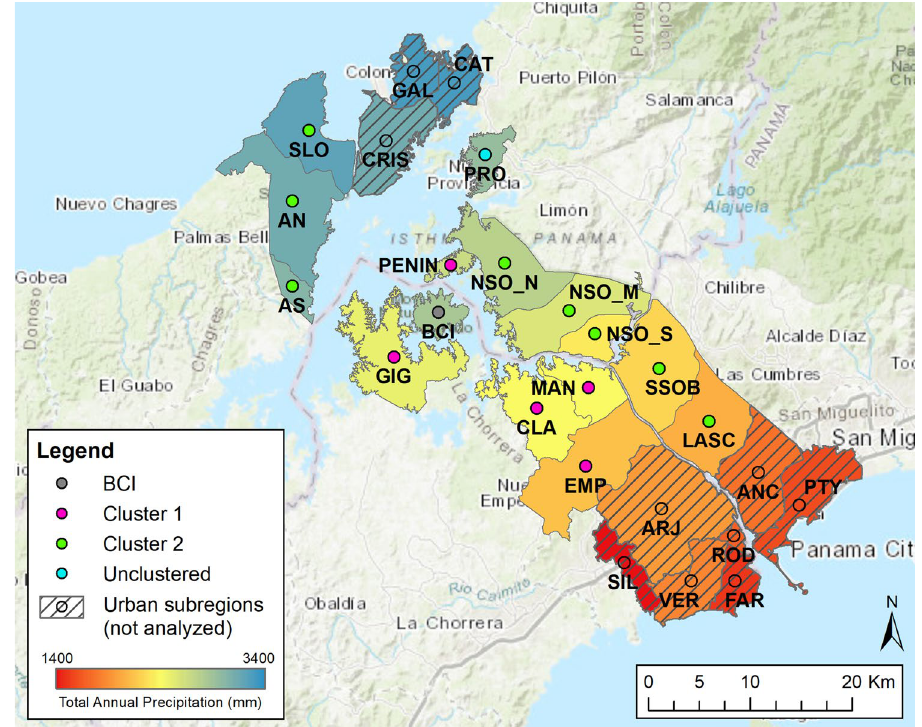
Figure 1. Digitized map of physiographic subregions along the Panama Canal modified from 37 . Colored dots indicate subregion group membership based on hierarchical cluster analysis (Fig. 2). Black lines indicate regions used for the study, with fill colors corresponding to mean total annual precipitation for that subregion. See Supplementary Table S7 for full names corresponding to abbreviated subregion